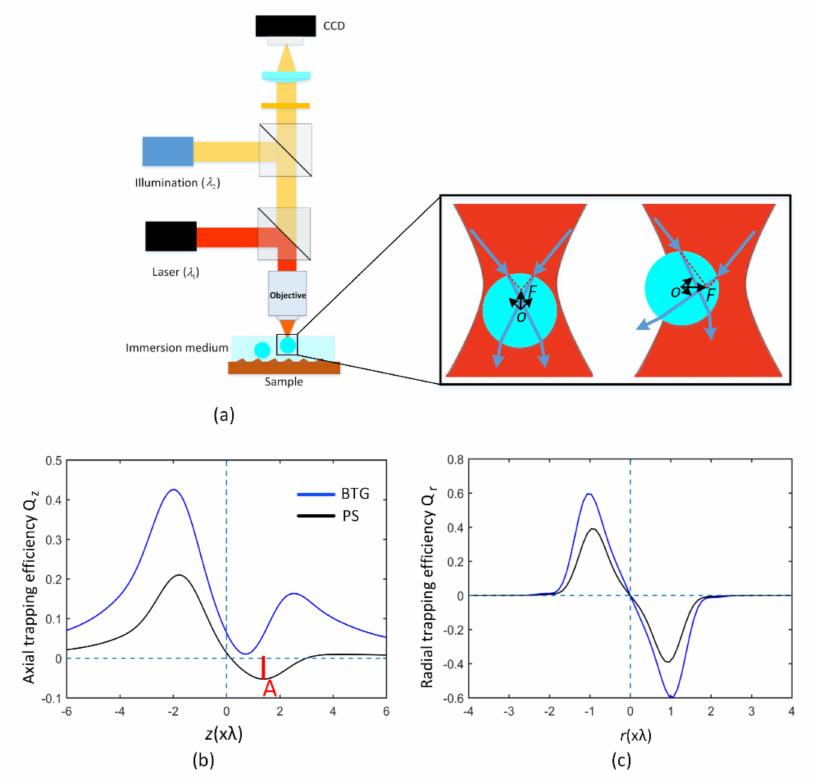
Figure 1. ( a ) Schematic of a normal optical system for the combination of single-beam optical trapping with microsphere-assisted microscopy. The same objective is utilized for both the optical trapping and the observation. The inset in ( a ) shows force on the microsphere in optical trapping with a Gaussian beam, in which the sphere is dragged toward to the region of high intensity. Axial ( b ) and radial ( c ) trapping forces of a barium titanate glass (BTG) sphere (blue line) and polystyrene (PS) sphere (black line) in optical trapping as a function of displacement from the focus. The force is given in terms of the dimensionless trapping e ffi ciency Q which can be converted to actual force by multiplying by n m P / c , where n m is the immersion index, P is the beam power at the focus and c is the light speed in free space. A linearly polarized 1064-nm Gaussian beam is used as the trapping beam, focused by an objective with numerical aperture of 1.0. These two spheres in water have the same radius of 0.8 µ m. The maximum reverse axial force A is shown in ( b ) and it characterizes the trap strength. The PS sphere can be trapped easily, while the BTG sphere is hard to